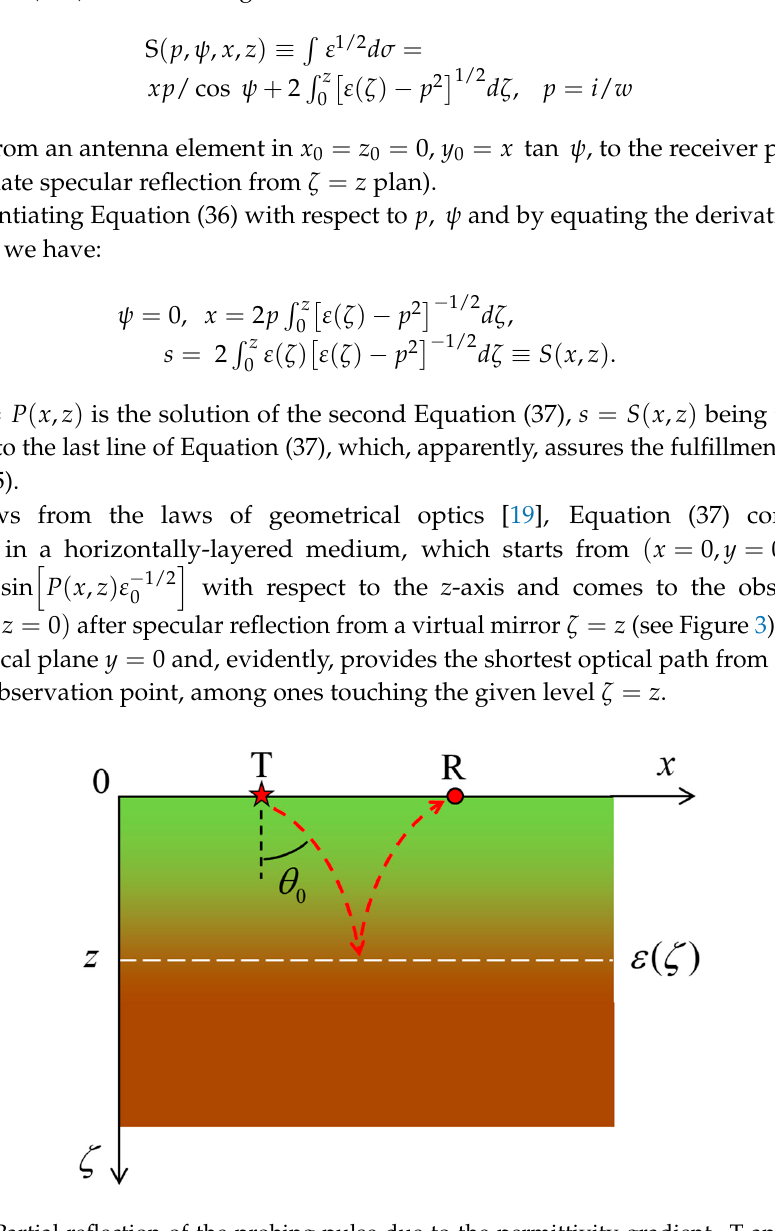
Figure 3. Partial reflection of the probing pulse due to the permittivity gradient. T and R are the transmitter and receiver positions, respectively. The red dashed line represents the GO path, while the white dashed line refers to an effective level of partial reflection.